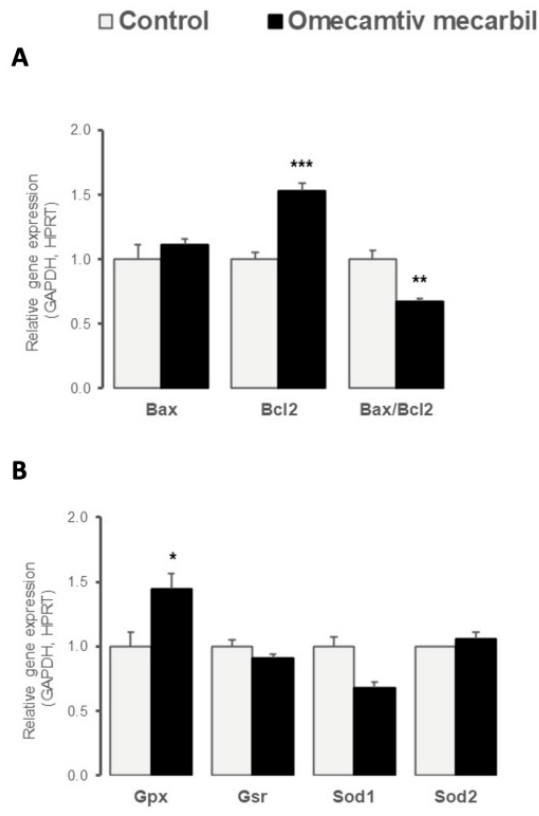
Figure 1. Myocardial left ventricular relative expression of genes implicated in ( A ) apoptosis ( Bax , Bcl2 ) and ( B ) oxidative stress ( Gpx , Gsr , Sod1 , Sod2 ) processes seven days after omecamtiv mecarbil (OM; n = 6; black bars) versus placebo (n = 8; grey bars) infusion. Values are presented as mean ± SD; * 0.01 < p < 0.05, ** 0.001 < p < 0.01, *** p <